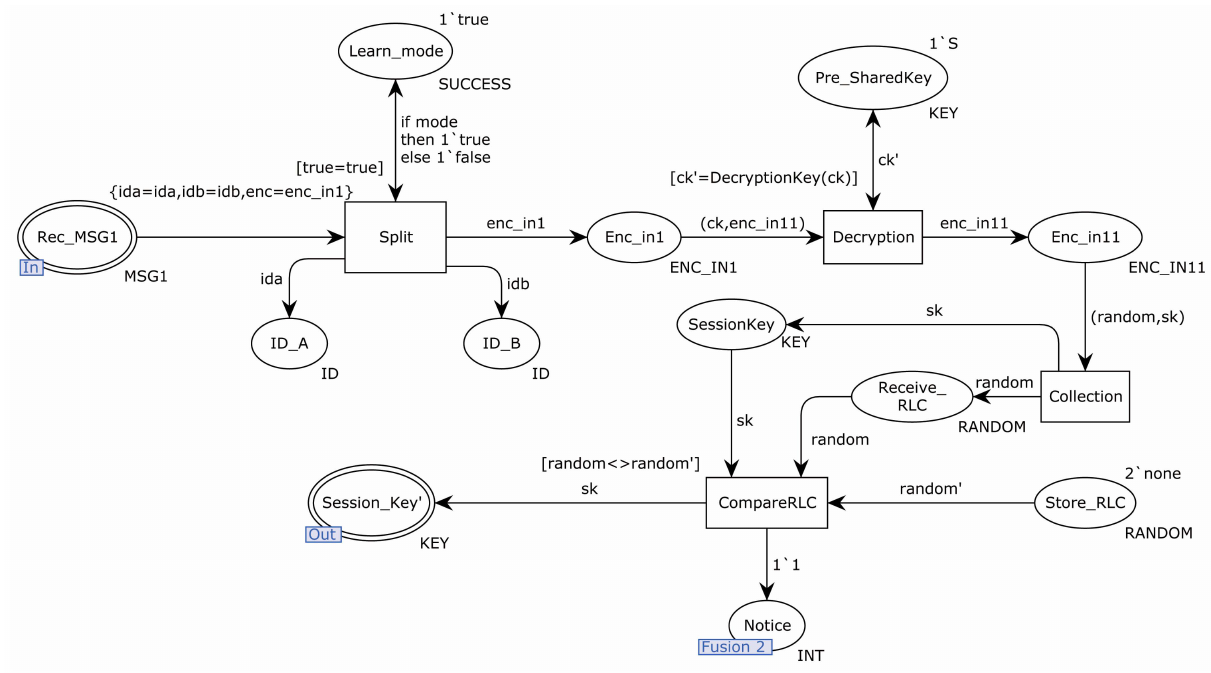
Figure 4. Substitution transition learn internal